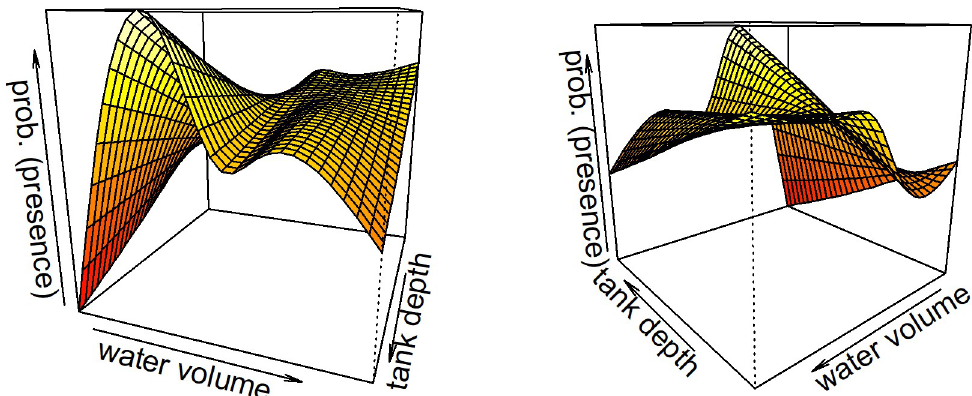
Fig 3. Tank depth and water volume interact non-linearly in the statistical model of reproductive site choice (“prob (presence)”). The non-linear two-factor response surface is shown from two different angles (a,b). Note how the general increase in preference with phytotelm size (bromeliad tank depth) is reversed at very low and very high water volumes, and the general increase in preference with water volume is reversed in very deep bromeliads.